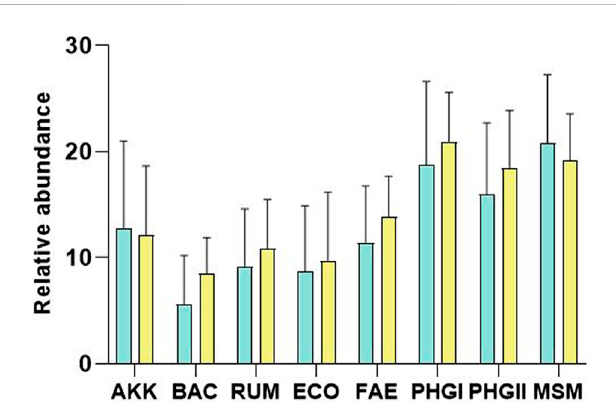
FIGURE 1 Plot of the relative abundances (Microbial marker Ct — Eubacteria Ct) of A. muciniphila (AKK), Bacteroidetes (BAC), Ruminococcus spp. (RUM), E. coli (ECO), F. prausnitzii (FAE), F. prausnitzii phylogroup I (PHGI), F. prausnitzii phylogroup II (PHGII), M. smithii (MSM) for remission (green) and recurrence patients (yellow). No signi fi cant differences were found ( p -value > 0.05). Note that results are shown in PCR Ct values, so a higher value indicates lower abundance than a lower